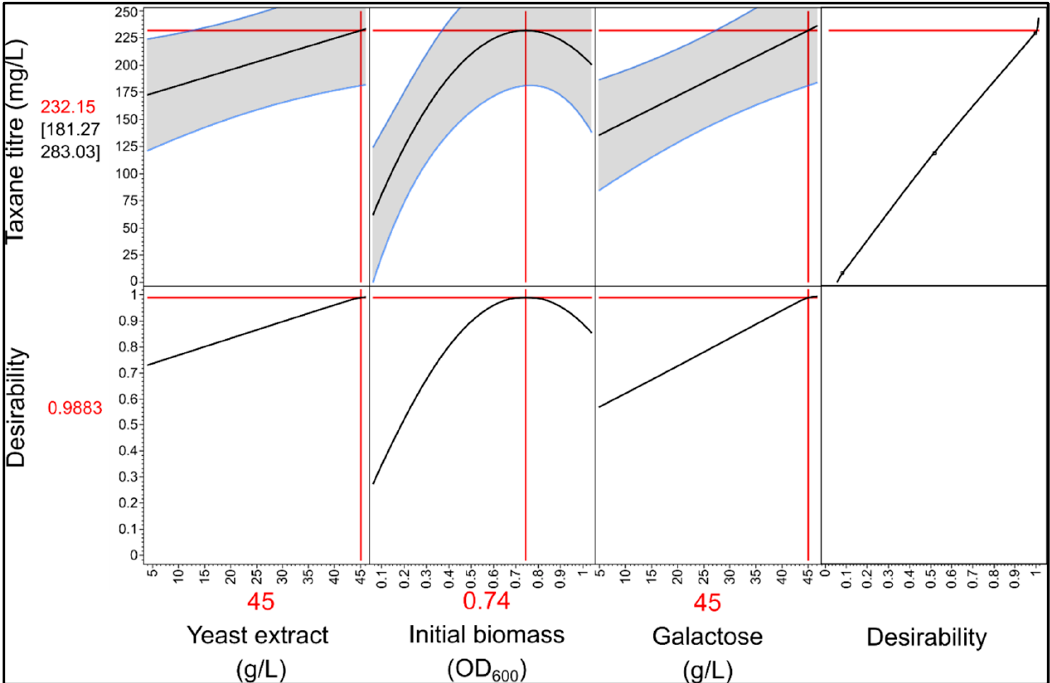
Figure 6. Optimization of taxane production using statistical modeling. The prediction profiler in JMP Pro 15 was used to determine the optimal factor combination according to the statistical model.